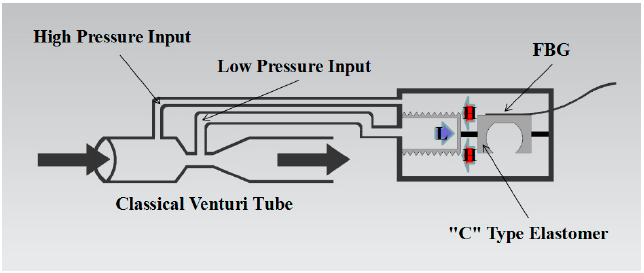
Figure 1. The typical structure of a differential pressure sensor in which an FBG may be used.